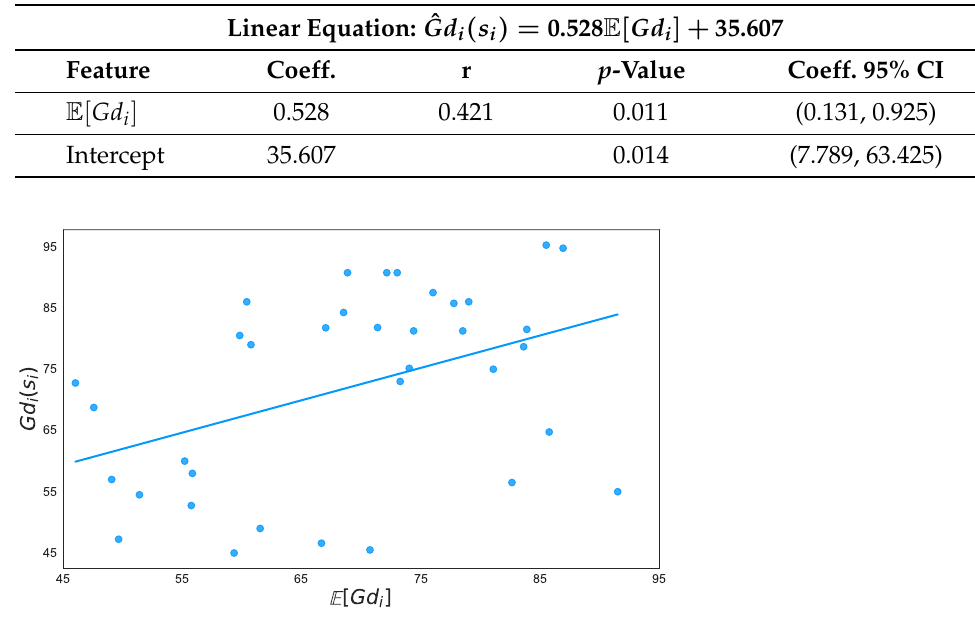
Figure 5. Random Student’s Grades against Discussion’s Grade Averages. r = 0.421, p = 0.011.